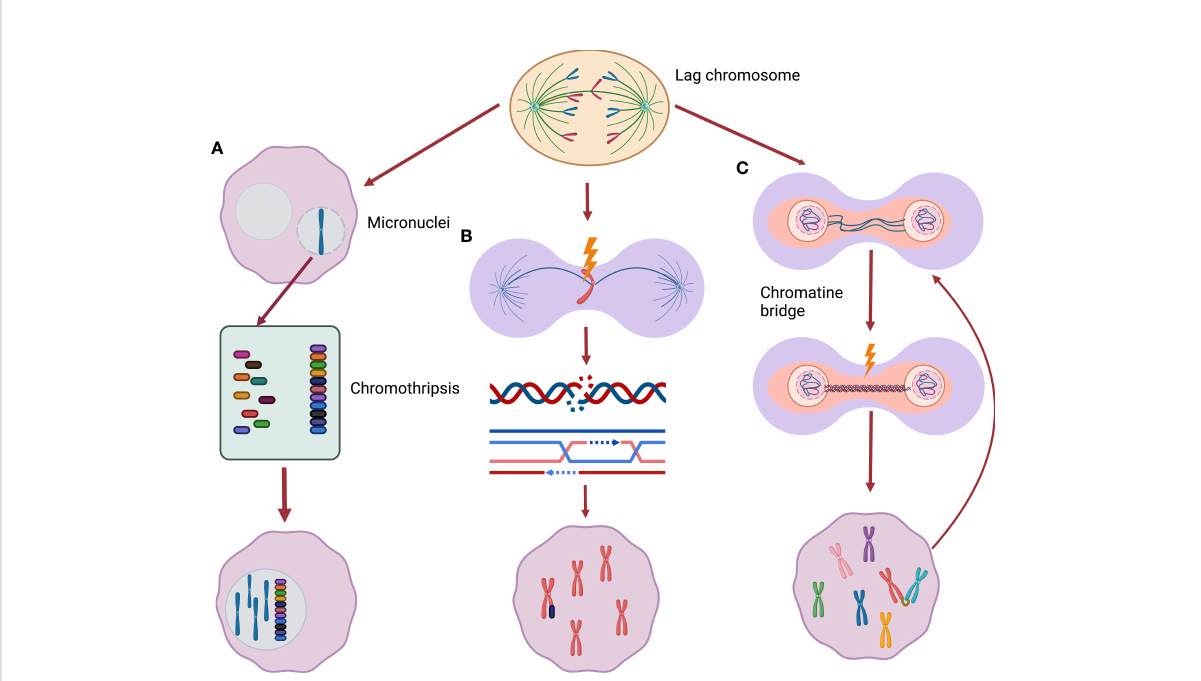
FIGURE 2 From whole chromosome mis-segregation to segmental alterations. (A) Lagging chromosomes may be incorporate into micronuclei, encountering chromothripsis (a phenomenon of massive chromatin fragmentation) during the following cell replication cycle. These severe rearranged chromosomes can be subsequently included back in the main nucleus. (B) Missegregated chromosomes can be frequently damaged during cytokinesis activating DNA double-strand break response leading to new segmental alterations. (C) Chromatin bridges can cause chromatin breakage triggering breakage-fusion-bridge cycle, a well described origin of segmental